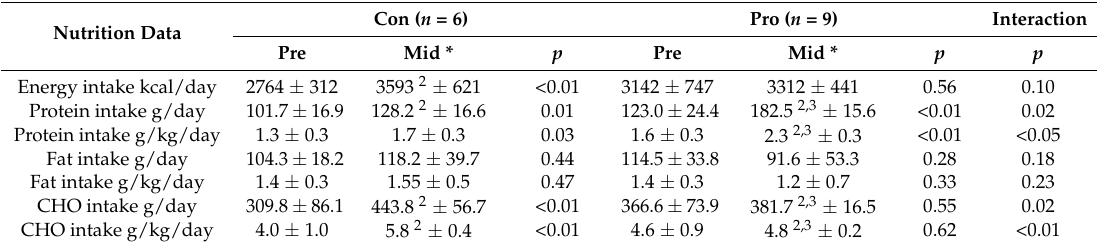
Table 3. Energy and macronutrient intake before (Pre) and during the intervention (Mid-intervention (Mid)) 1 .